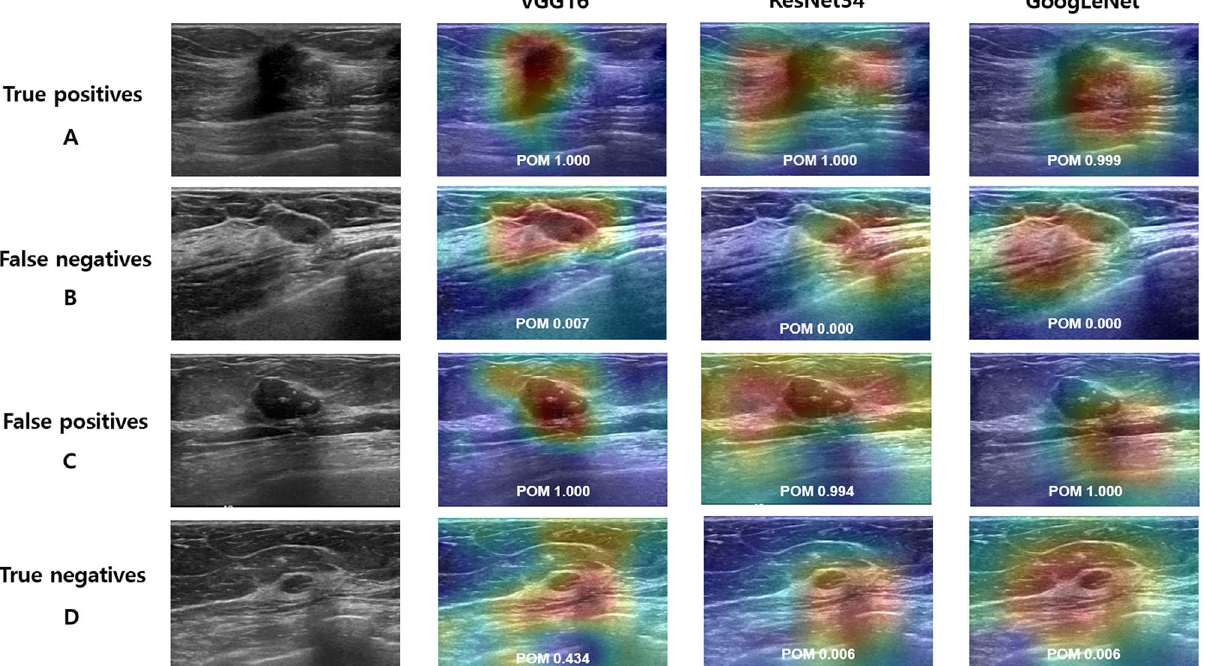
Figure 3. Classification results with class activation map (CAM) using the weakly-supervised deep learning (DL) algorithm on external validation set. Examples of true-positive ( A ), false-negative ( B ), false-positive ( C ), and true-negative ( D ) are shown for each network (VGG16, ResNet34, and GoogLeNet). ( A ) Ultrasound images show a 17-mm irregular, spiculated invasive ductal carcinoma, which was predicted as malignancy with probability of malignancy (POM) of 1.00, 1.00, and 0.999 in VGG16, ResNet34, and GoogLeNet, respectively. ( B ) Ultrasound images show an 11-mm oval, circumscribed, isoechoic mucinous carcinoma, which was predicted as benign with POM of 0.007, 0.000, and 0.000, respectively. ( C ) Ultrasound images show a 29-mm oval, hypoechoic mass with macrocalcifications considered as benign (unchanged during the 46-month follow-up period), which was predicted as malignancy with POM of 1.000, 0.994, and 1.000, respectively. ( D ) Ultrasound images show a 6-mm oval, circumscribed mass considered as benign (unchanged during the 55-month follow-up period), which was predicted as benign with POM of 0.434, 0.006, and 0.006,